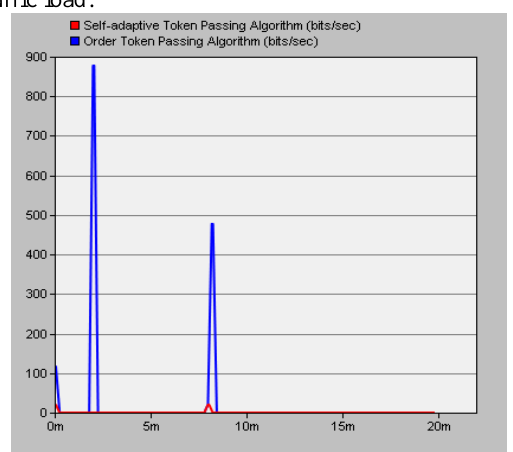
Fig.4 Improvement on frame